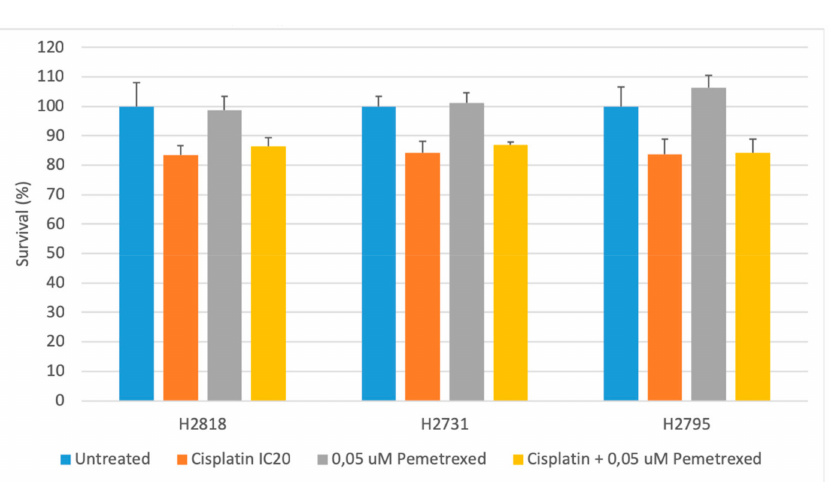
Figure 2. Cytotoxic e ff ect of a combination of cisplatin and pemetrexed. The graph represents the percentage cell survival of three MPM cell lines (NCI-H2818, NCI-H2731 and NCI-H2795) after 72 h